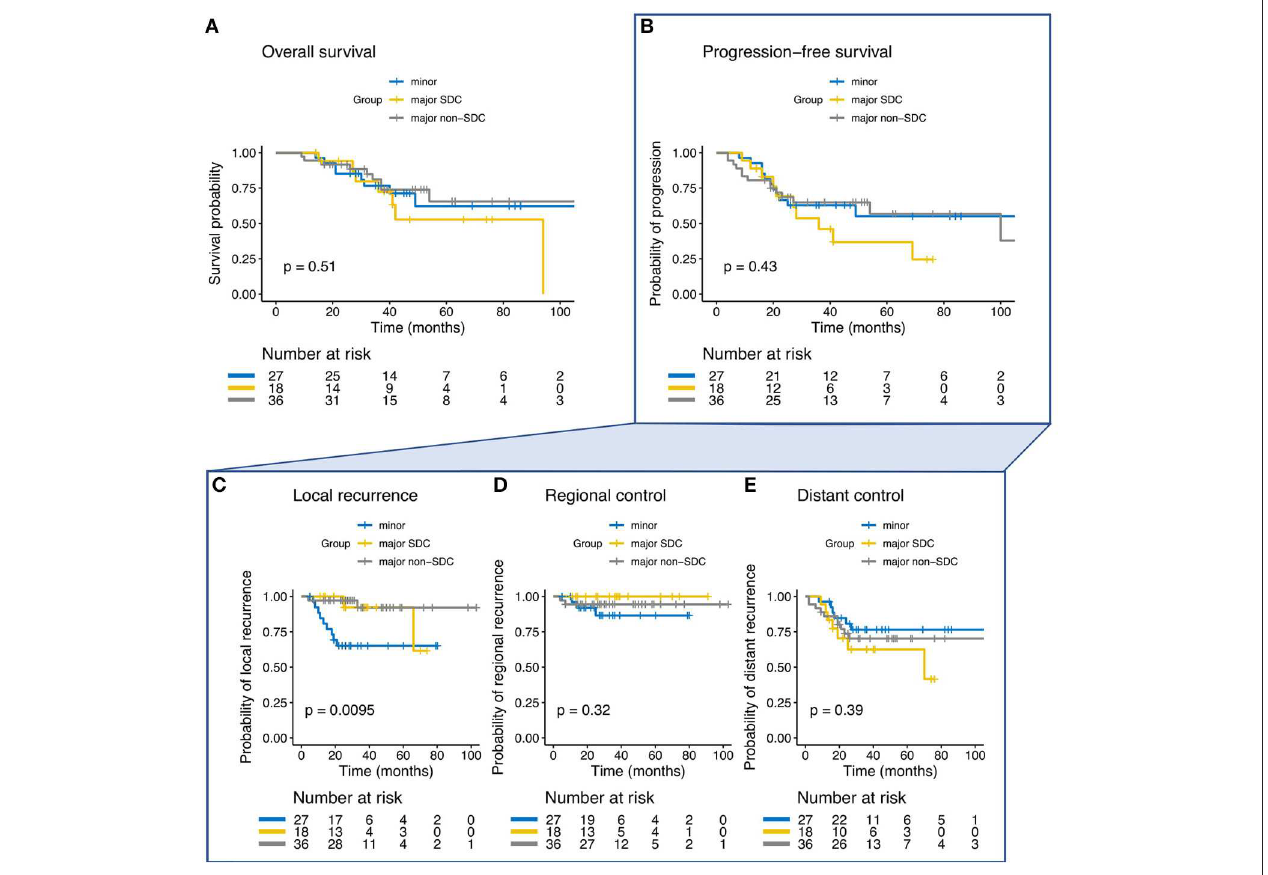
FIGURE 1 | (A–E) Kaplan-Meier estimates and p -values for overall survival, progression-free survival (PFS), local control, regional control, and distant control in dependence of the three groups of salivary gland adenocarcinoma (SGAC), salivary duct adenocarcinoma (SDAC), and intestinal-type adenocarcinoma